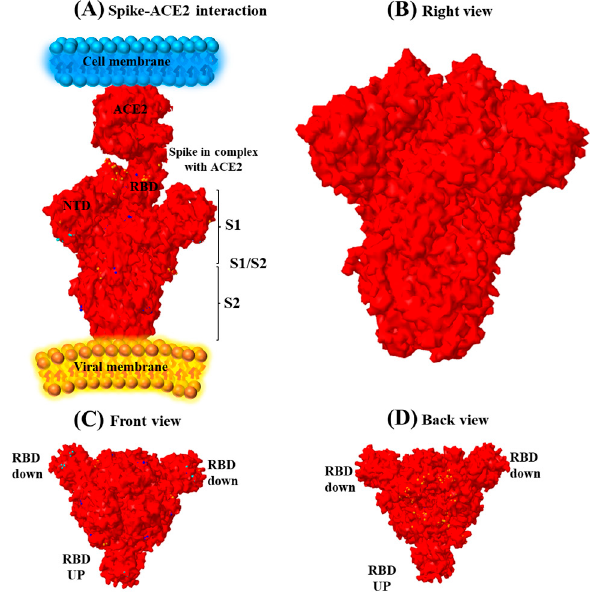
Figure 2. Structure of spike protein. ( A ) Different parts of spike protein include the N-terminal domain (NTD), receptor-binding domain (RBD), and S1 and S2 subdomains. The spike protein is attached to the ACE2 receptor by RBD. ( B ) Right view of the spike protein. ( C ) Front view of the spike protein. ( D ) Back view of the spike protein.